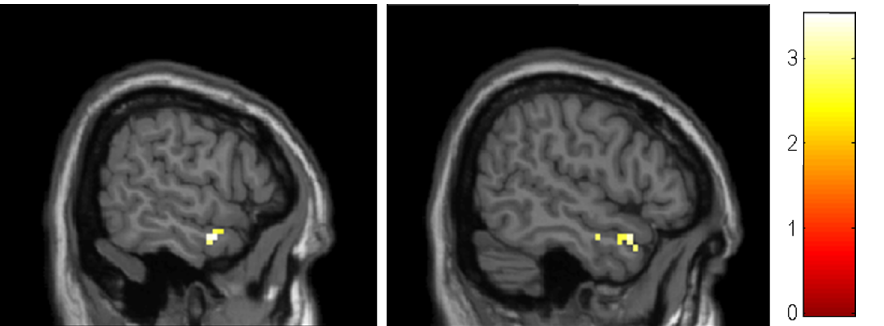
Figure 3. Brain regions showing decreased connectivity to right hippocampus in AD group comparing to control group. Left in picture is left in the brain. The color scale represents t values. Warm color represents decreased connectivity.